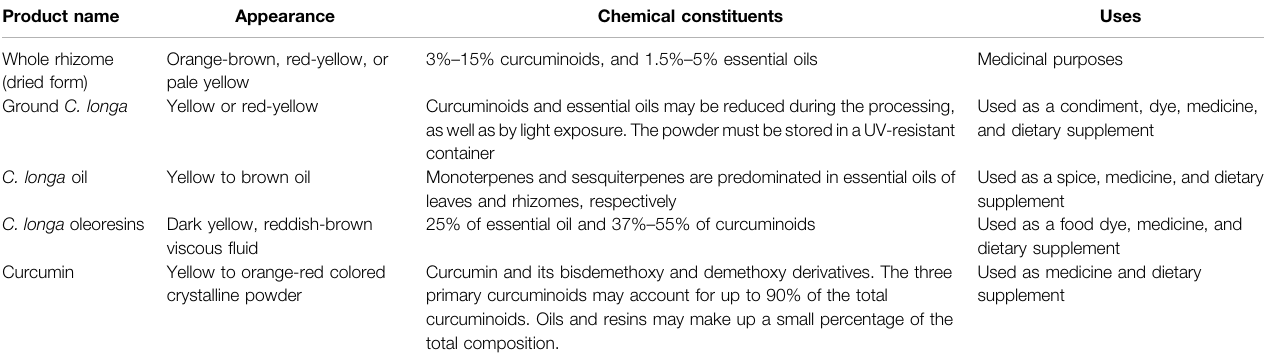
TABLE 1 | The main products of C. longa , their appearance, chemical constituents, and